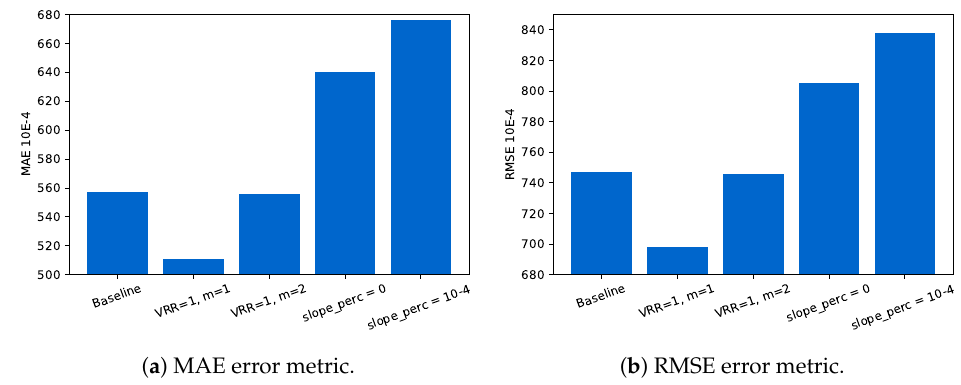
Figure 6. Error values for the GRU regression model.